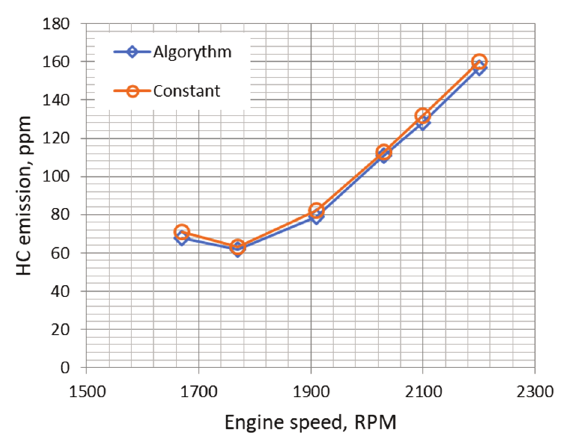
Fig. 11. Relationship between HC emission and rotational speed for con- stant and variable ignition advance angle